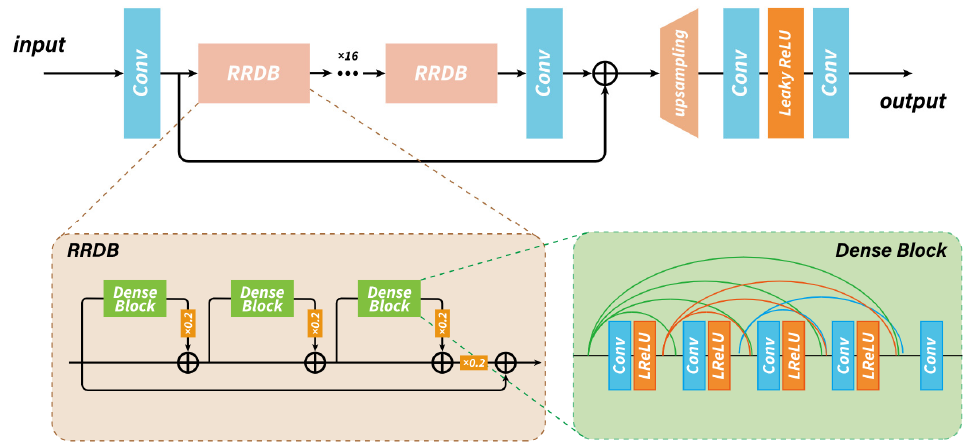
Figure 4. The architecture of RRDBnet. RRDBnet contains several RRDB; the yellow box and the green box are the details of RRDB and Dense block, respectively. ⊕ means element-wise addition.